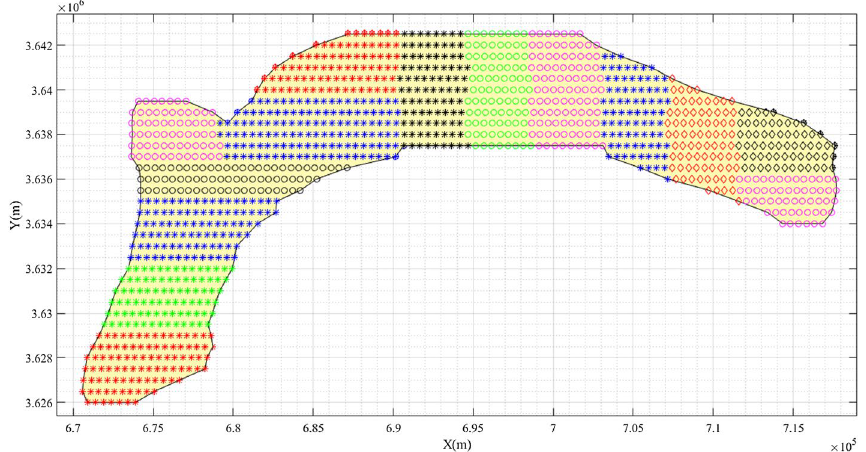
Fig. 5 Considered 14 different zones in Birjand